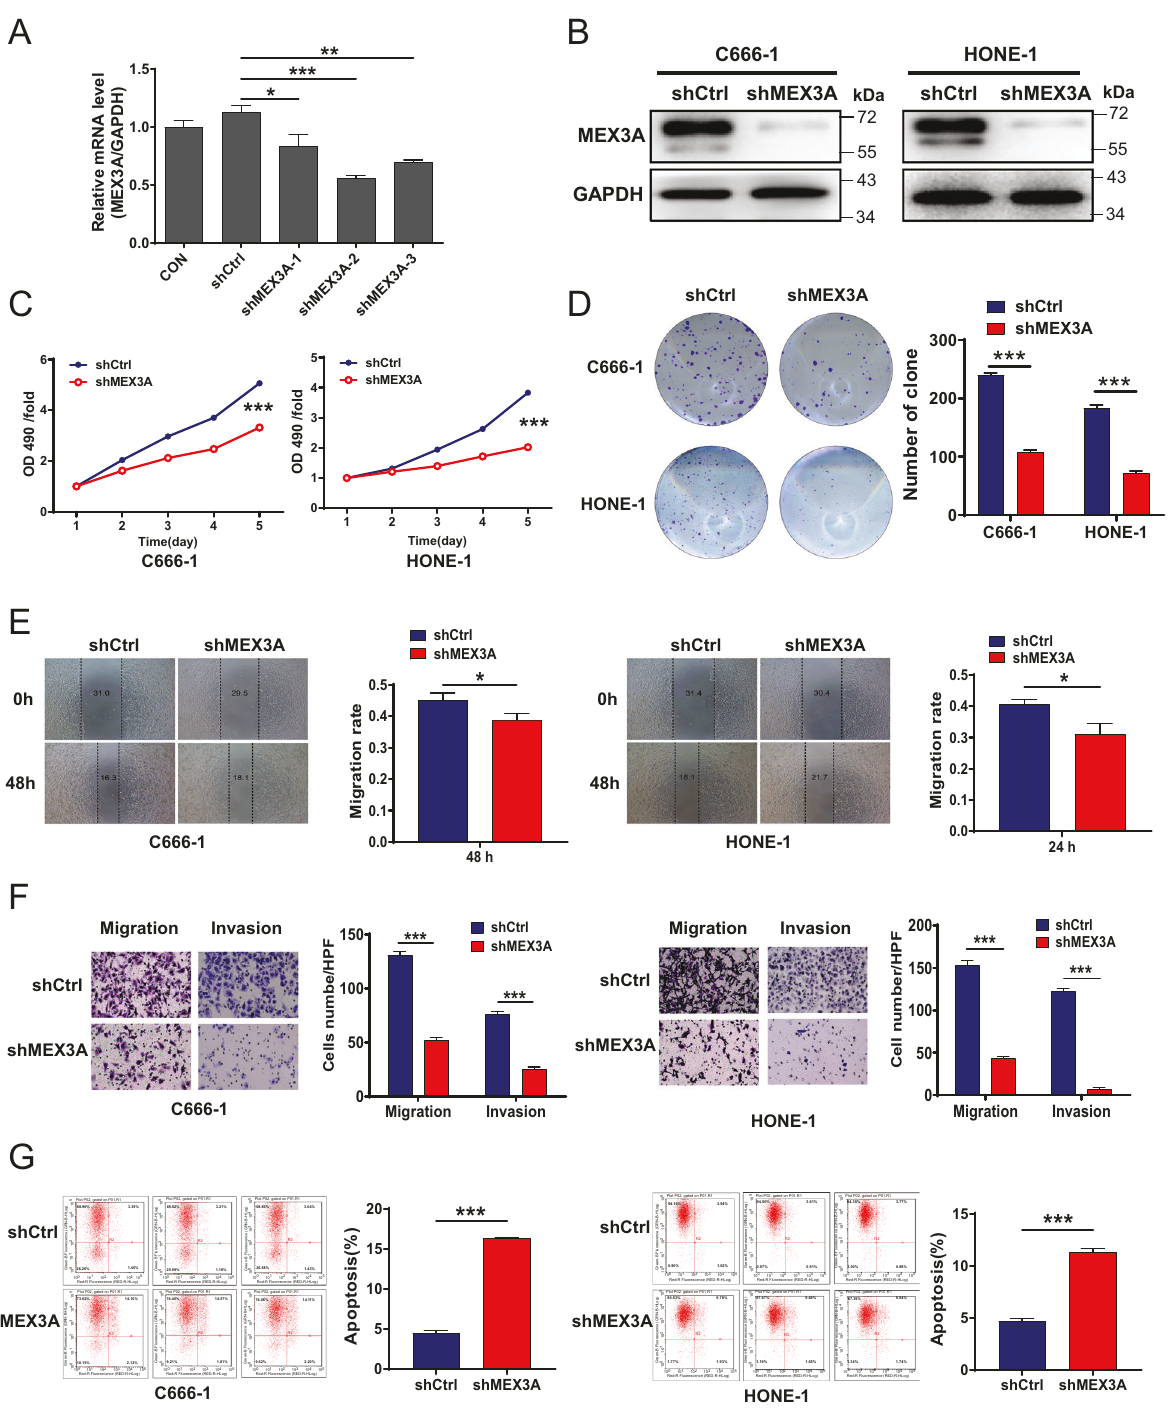
Fig. 2 MEX3A knockdown leads to decreased proliferation, migration, and invasion as well as increased apoptosis in NPC cell lines. A The knockdown ef fi ciencies of various MEX3A shRNAs in C666-1 cells were determined by qRT-PCR. B MEX3A protein levels in shCtrl and shMEX3A stable C666-1 and HONE-1 cell lines were detected by western blotting. C Cell proliferation rates of C666-1 and HONE-1 cells after shCtrl and shMEX3A lentivirus infection were determined by MTT assay. D Colony formation abilities of C666-1 and HONE-1 cells infected with shCtrl or shMEX3A lentivirus were detected by colony formation assay. E Migration rates of C666-1 and HONE-1 cells were determined by wound healing assay at 0, 24, and 48 h after infection. F Migration and invasion abilities of C666-1 and HONE-1 cells infected with shCtrl and shMEX3A lentivirus were determined by Transwell assay. Magni fi cation: 200×. G The effect of MEX3A knockdown on cell apoptosis was measured by fl ow cytometry. * P < 0.05, ** P < 0.01, *** P < Western blotting and co-immunoprecipitation (co-IP) assay Protein concentrations were measured using a BCA Protein Assay Kit (HyClone-Pierce, Logan, UT, USA). The proteins were resolved by 10% SDS- Cells were lysed in ice-cold RIPA buffer (Millipore, Temecula, CA, USA) PAGE (Invitrogen) and transferred to PVDF membranes. The membranes containing protease inhibitors (Roche Diagnostics, Basel, Switzerland).